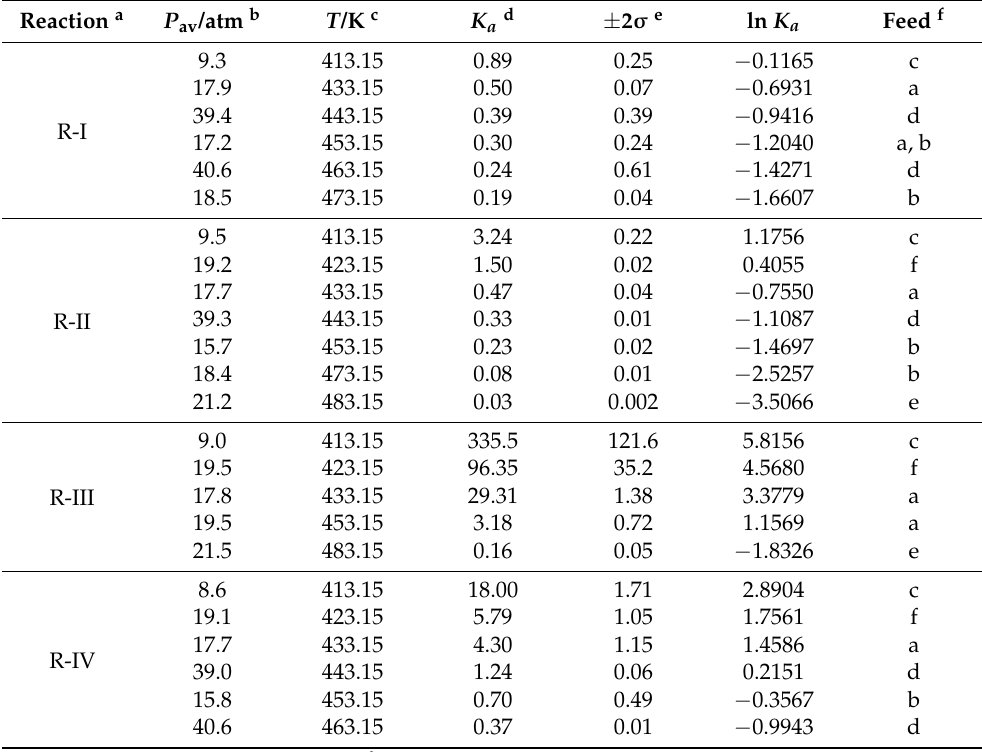
Table 1. Reaction parameters and calculated values of the liquid phase reactions R-I to R-IV. Reaction